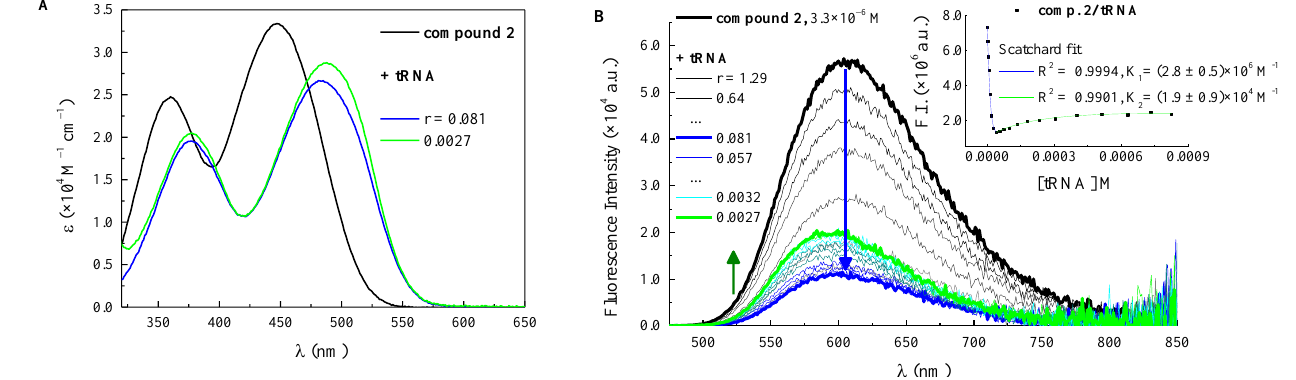
Figure 1. ( A ) quantitative absorption spectra of 2 and its complexes with tRNA in ETN buffer solution, pH 7.4, with r = [compound]/[nucleic acid]. ( B ) changes in the fluorescence spectrum of 2 ( λ exc = 448 nm, c = 3.3 µ M) in ETN buffer solution, pH 7.4, upon titration with tRNA; Inset: fluorescence intensity of 2 as a function of tRNA concentration and its fitting according to the Scatchard equation (n = 0.2).